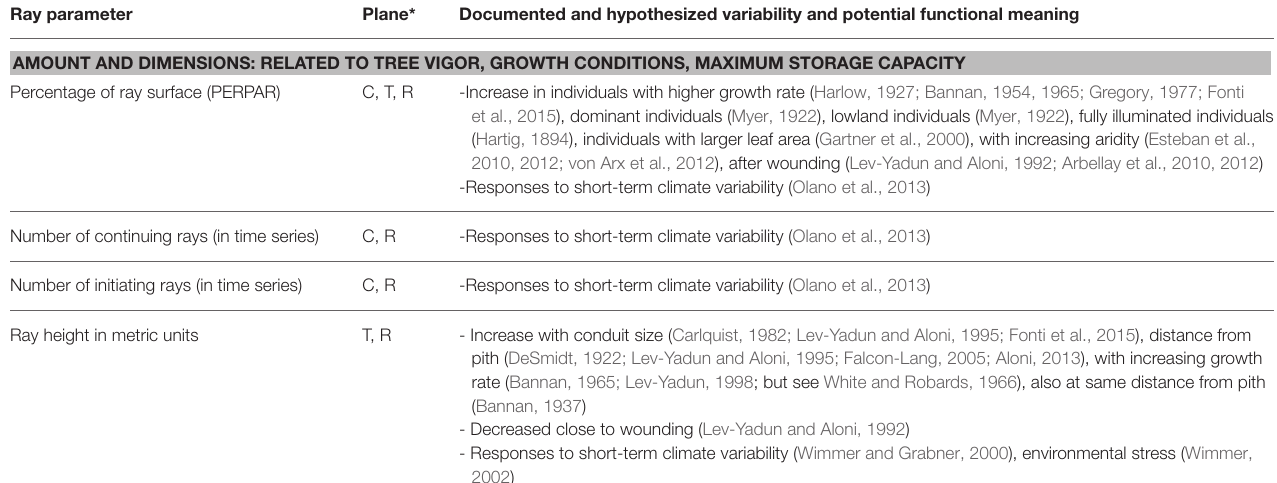
TABLE 1 | Literature review of measured anatomical ray parameters and the inferred ecological interpretation of their variability. Ray parameter Plane